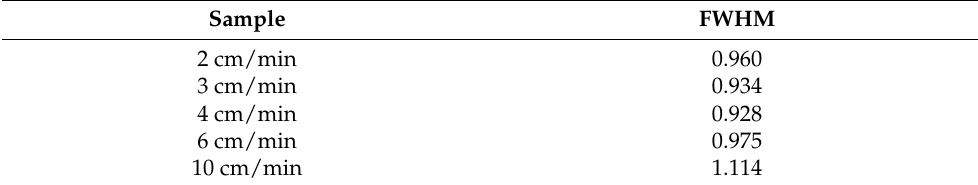
Figure 5. XRD curves of CNTs/CF multiscale reinforcements prepared at different moving speeds. The flow rate of H 2 and C 2 H 2 was 0.3 L/min. Table 2. FWHM values at 2θ = 25.3°.